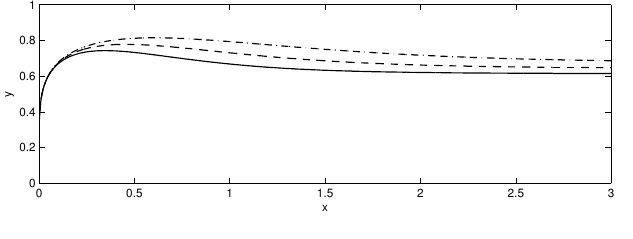
Figure 3. Plot of y exact /y asym as in (4.2) for µ = 1, α = 0 . 5, λ = 0 . 5 (dot-dash), 1 (dash) and 2 (solid line).